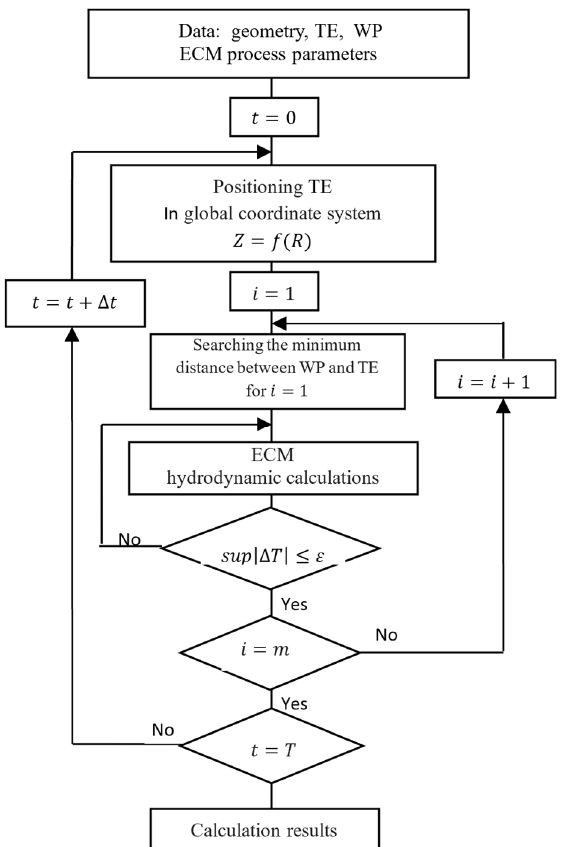
Figure 4. ECM process simulation algorithm (markings: i, m—current, and the last point of the curve describing the WP).